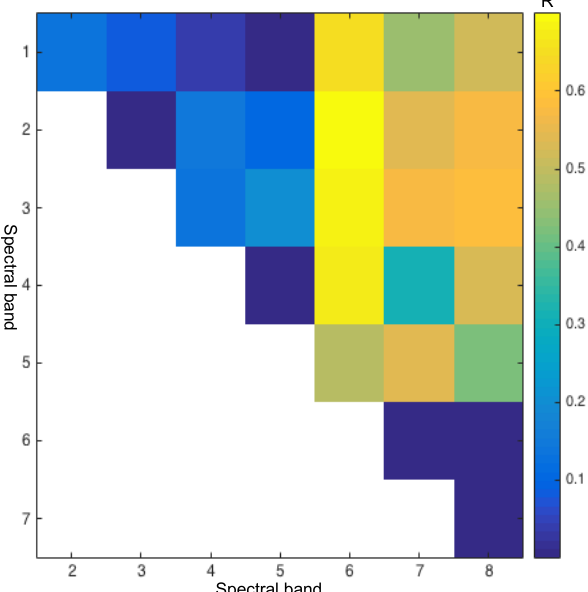
Figure 3. Optimal Band Ratio Analysis (OBRA) using WV-3 image